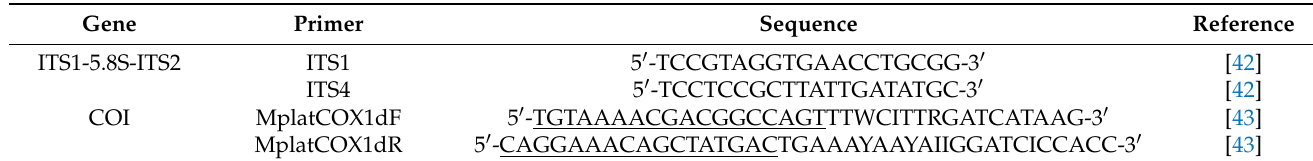
sequences were clipped. Sequences were deposited in GenBank (Table 2). Closest matches of sequences were identified by a BLAST search against GenBank entries [40]. Table 1. Primers used for amplification and sequencing. The M13 sequences [M13(-21)F and M13(-27)R] at the 5’ ends of the degenerated COX1 primers are underlined. Gene Primer Sequence Reference ITS1-5.8S-ITS2